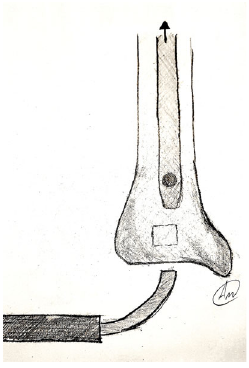
Figure 20. Distal tibial cortical windowing–bone tamp.